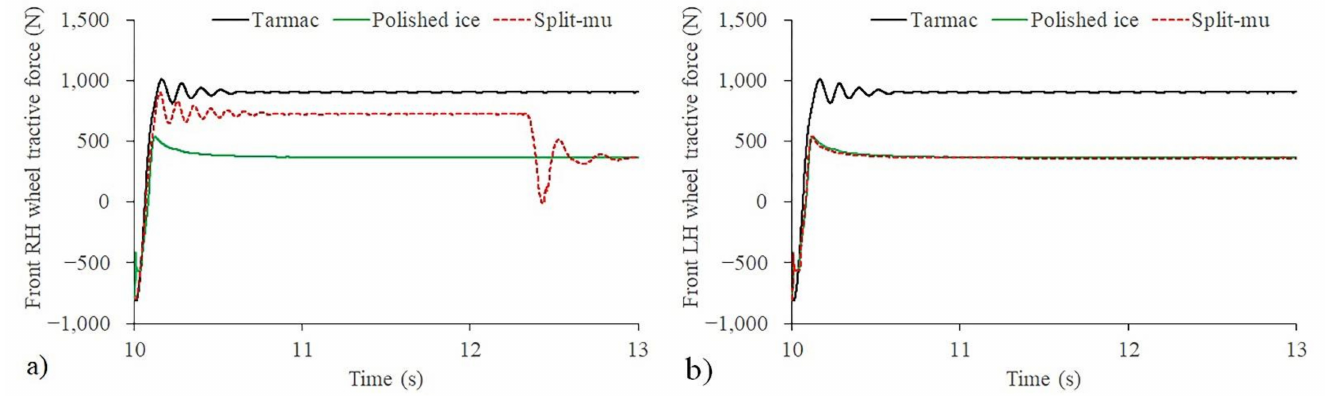
Figure 8. Tip-in event tractive force on different road mu: ( a ) front RH wheel; ( b ) front LH